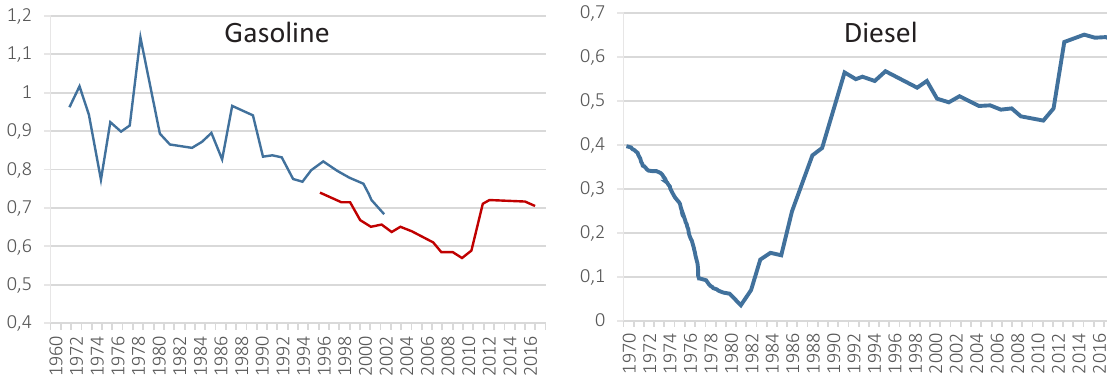
Figure 2. Excise duties on gasoline and diesel (EUR per liter, real prices in 2017)